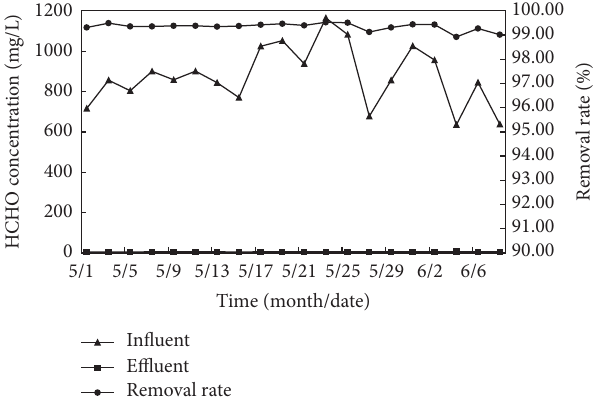
Figure 2: Formaldehyde removal from the reactor.